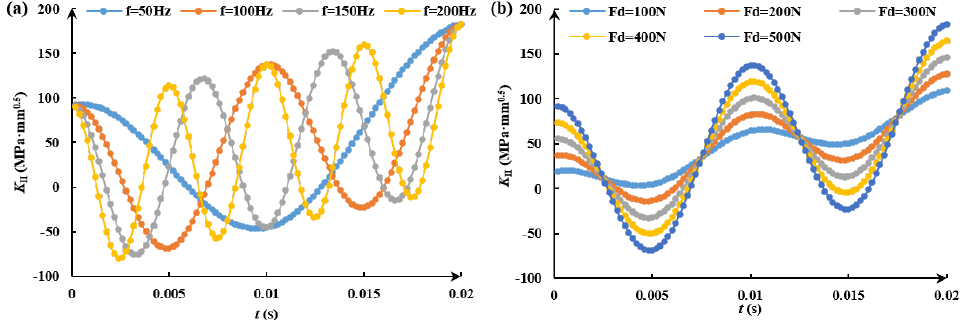
Figure 9. Variation curves of stress intensity factor at crack tip with time under different harmonic dynamic loads: ( a ) different frequencies; ( b ) different amplitudes.